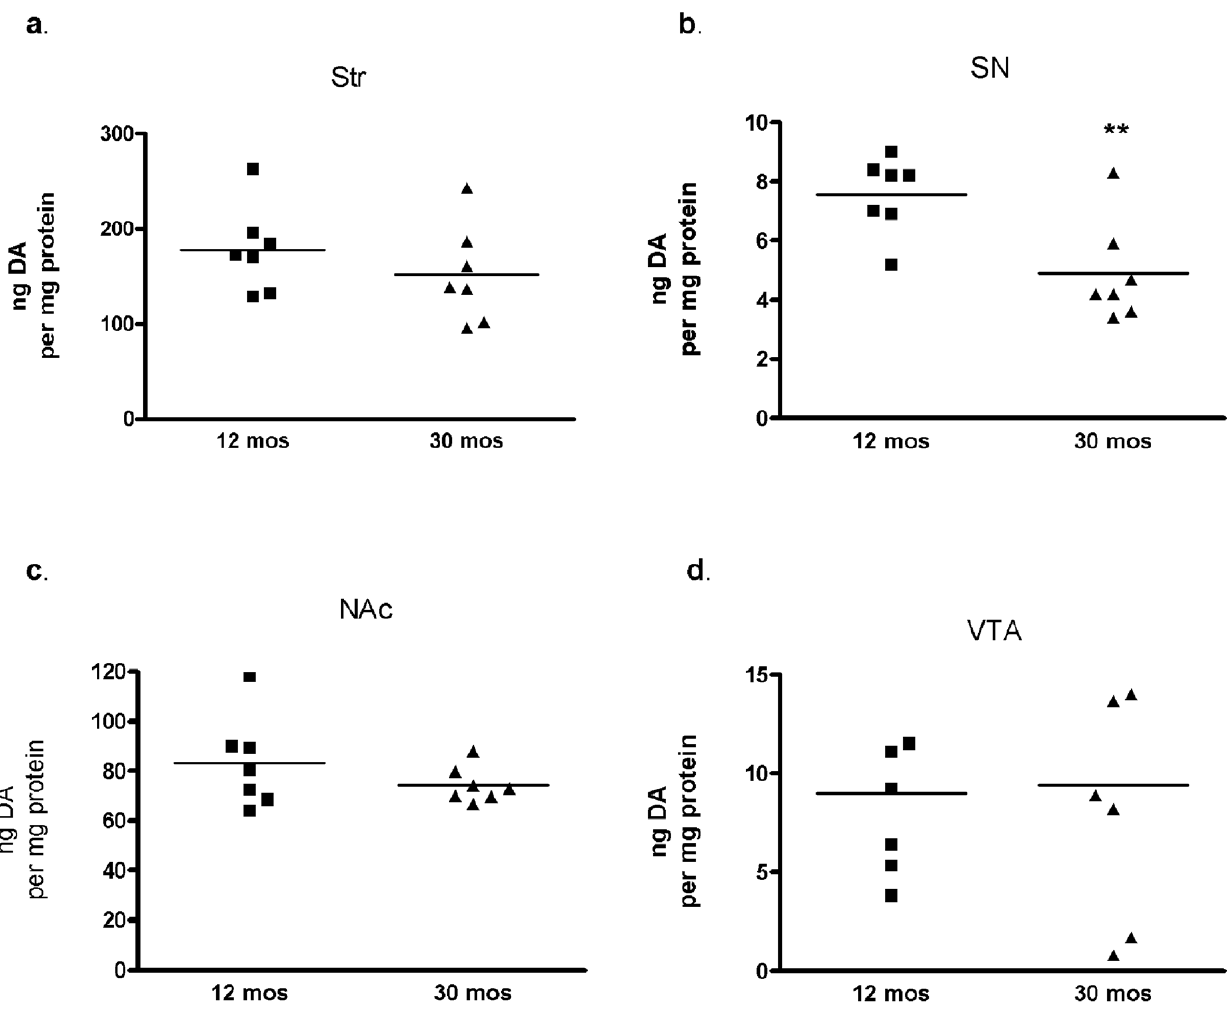
Figure 6. Aging and DA tissue content. Values are ng DA/ mg protein in 12- and 30-month old subjects in the nigrostriatal (a, b) and mesoaccumbens (c, d) dopaminergic pathways. a. striatum , ns, 12 mo.,178 6 17, 30 mo., 152 6 19, b. substantia nigra , ** p , 0.01, 12 mo., 7.6 6 0.5, 30 mo. 4.9 6 0.6, c. nucleus accumbens , ns, 12 mo., 83 6 6.9, 30 mo. 74 6 2.8, d. ventral tegmental area , ns, 12 mo., 9.0 6 1.5, 30 mo., 9.4 6 2.5. These statistical relationships (Student’s t-test, unpaired) also held in the comparison of total DA recovery (not normalized to protein) in each region (Fig S4).